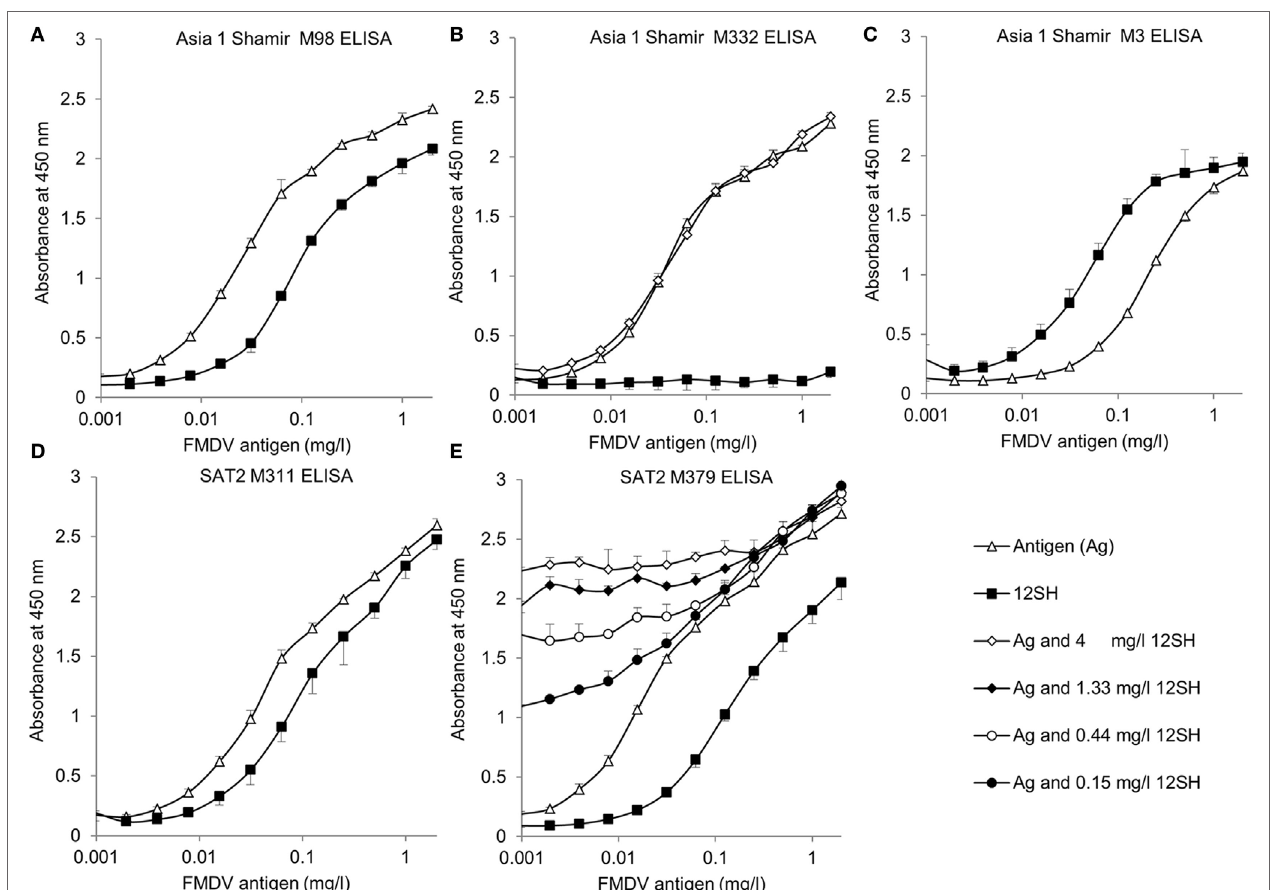
FigUre 1 | Titration of foot-and-mouth disease virus (FMDV) antigens or 12S H particles derived thereof in double antibody sandwich (DAS) enzyme-linked immunosorbent assays (ELISAs). FMDV strains Asia 1 Shamir (a–c) and SAT2 SAU/2/00 (D,e) were used. The different DAS ELISAs employed the same VHH for coating in unlabeled form and for detection in biotinylated form. The different VHHs used are indicated above the panels. Antigen or 12S H particles were twofold titrated with a starting concentration of 2 mg/l. The two ELISAs using 146S-specific VHHs (b,e) were also titrated with a 2-fold dilution series of antigen to which a constant amount of 12S H particles was added. In the legend the concentration of the constant amount of 12S H particle is indicated. ELISAs were performed in triplicate. Mean and SD are